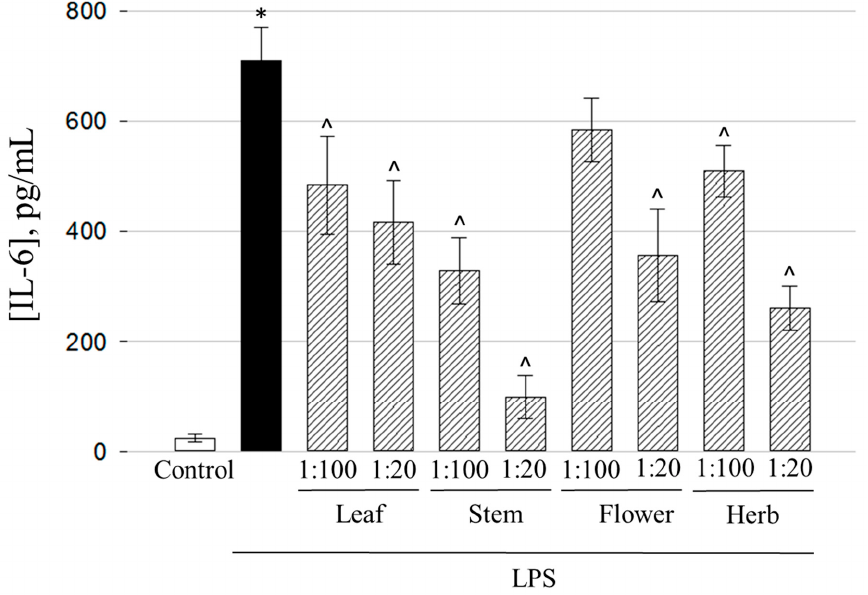
Figure 7. The effect of extracts obtained from different E. ciliata parts on LPS-induced IL-6 secretion. Results are presented as means ± SD. * Significant difference compared to the Control, ^ compared to the LPS-only treatment ( p < 0.05), one-way ANOVA with Tukey’s test.